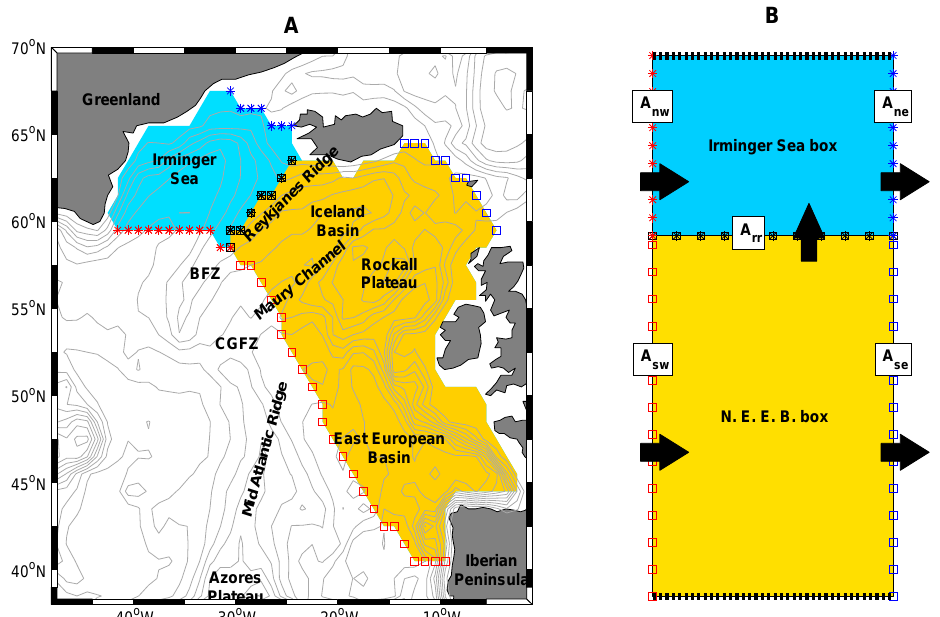
Fig. 1. (A) Localizations of the Irminger Sea (light blue shaded area) and northeastern European basin (NEEB, yellow shaded area) boxes. Main geographic and topographic features are indicated. (B) The associated two box model simplified schematic. Black arrows indicate the convention for horizontal positive transports. The white-background labels indicate face labelling convention, here applied to the surface A of faces. Blue/red star/square marks are drawn to help localize faces from panel (A) to (B) . Table 1. A priori state estimates of optimized